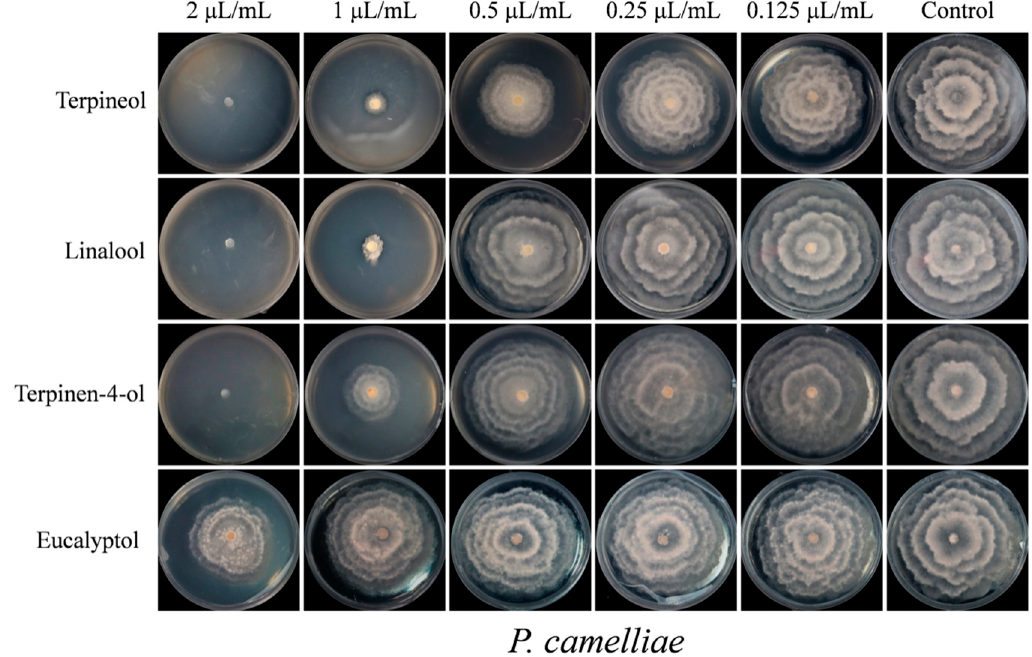
Figure 6. The mycelial growth of P. camelliae treatment by four mainly activity compounds with contact antifungal activity after 7